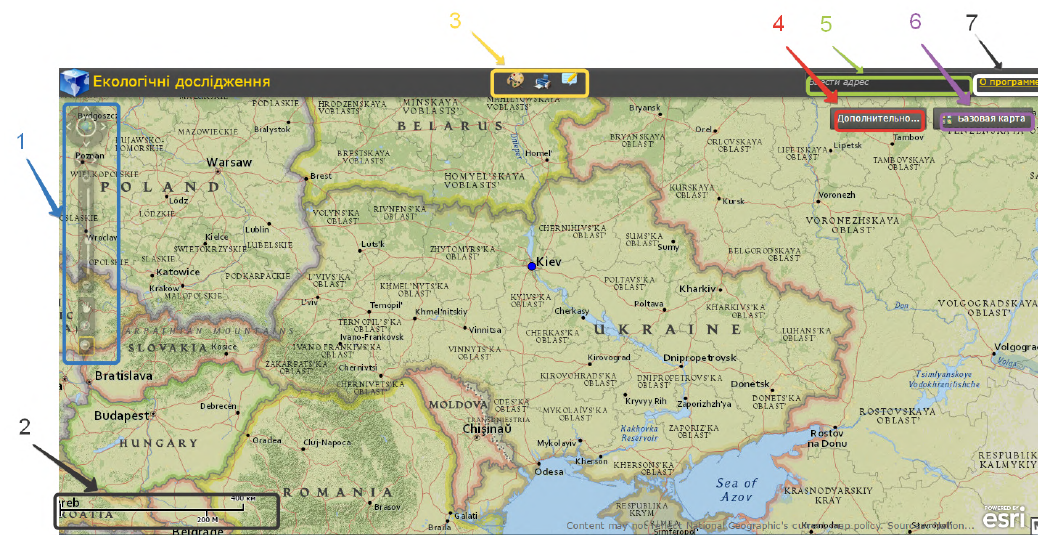
Figure 9: General view of the